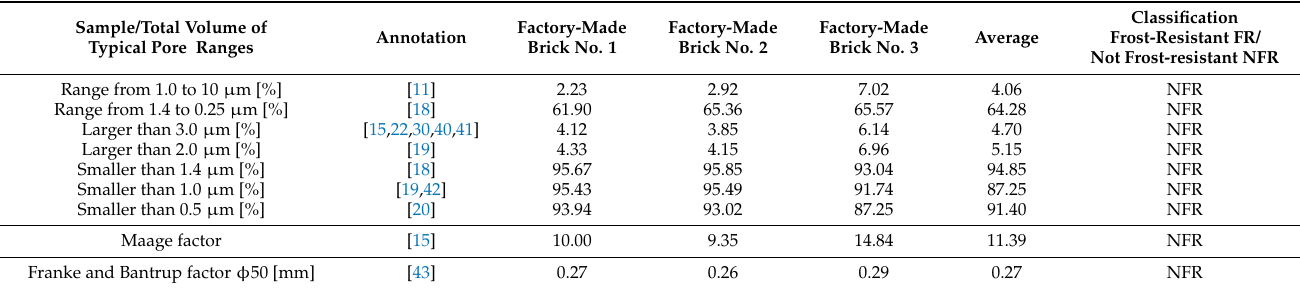
Table 8. Factory-made brick frost resistance prediction models.